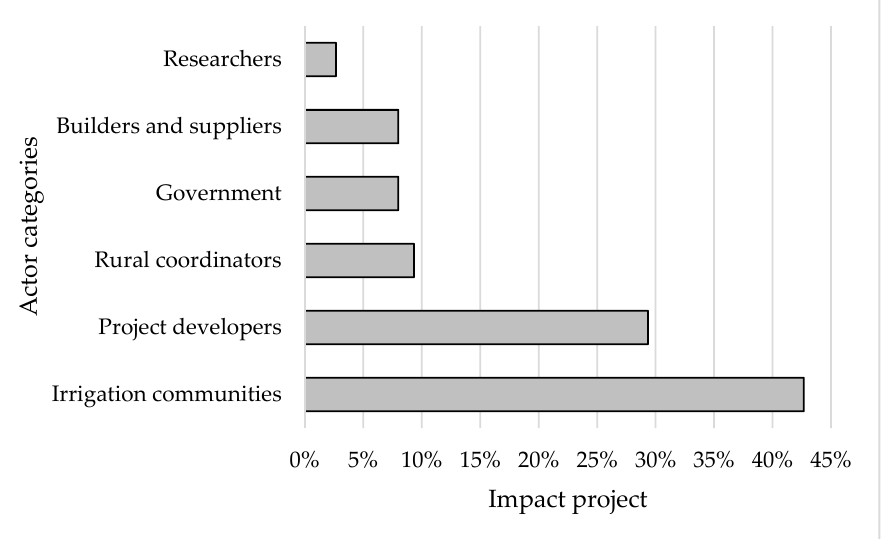
Figure 5. Incidence of nodes by actor category.